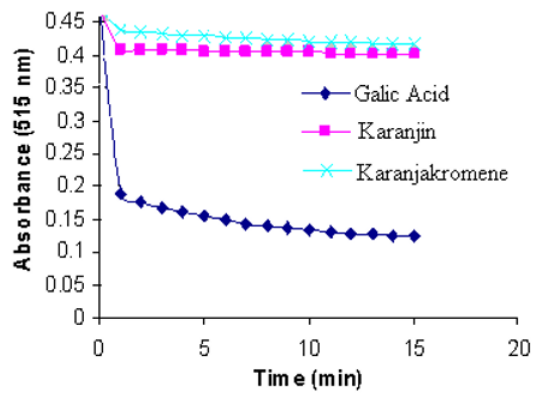
Figure 6. Time course of absorption reduction of DPPH-Test samples (0.01 M); karanjin and karanjachromene in methanol. DPPH-Gallic Acid (10 -5 M) in methanol is used as positive